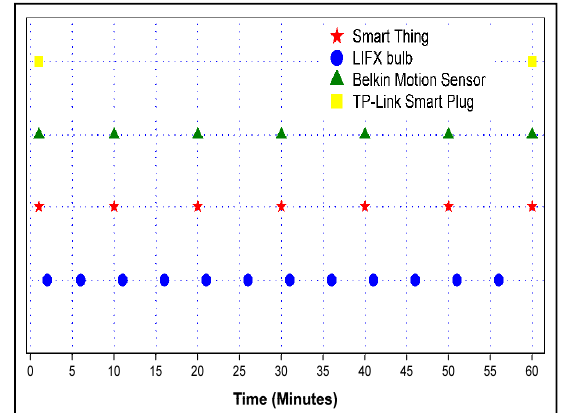
Fig. 9: NTP packets pattern of devices